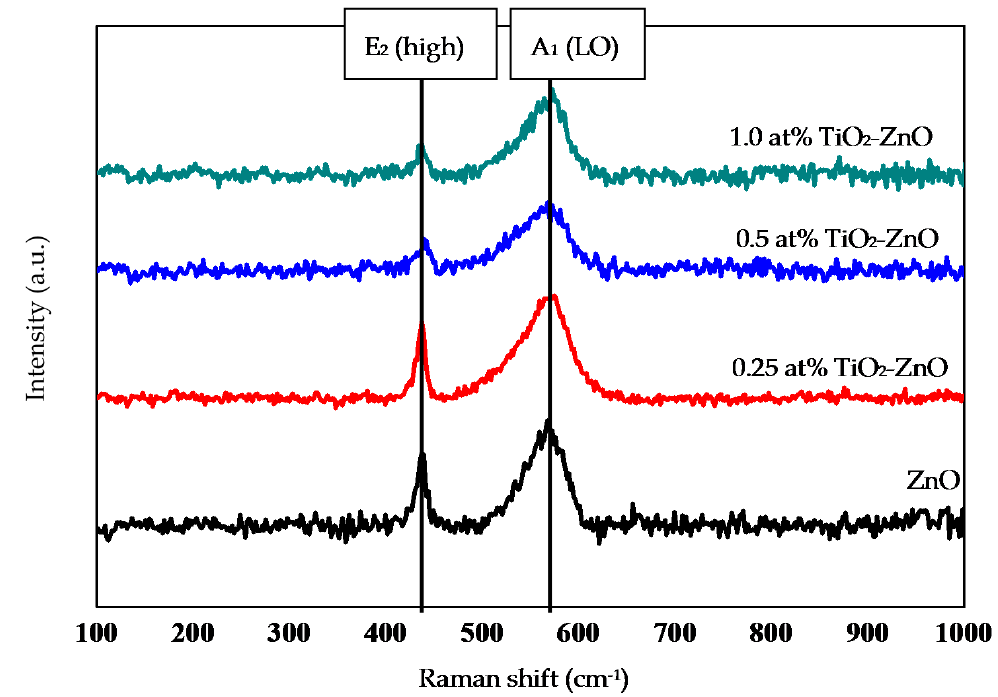
Figure 4. Raman scattering of ZnO, 0.25 at % TiO 2 -ZnO, 0.5 at % TiO 2 -ZnO, and 1.0 at % TiO 2 -ZnO.